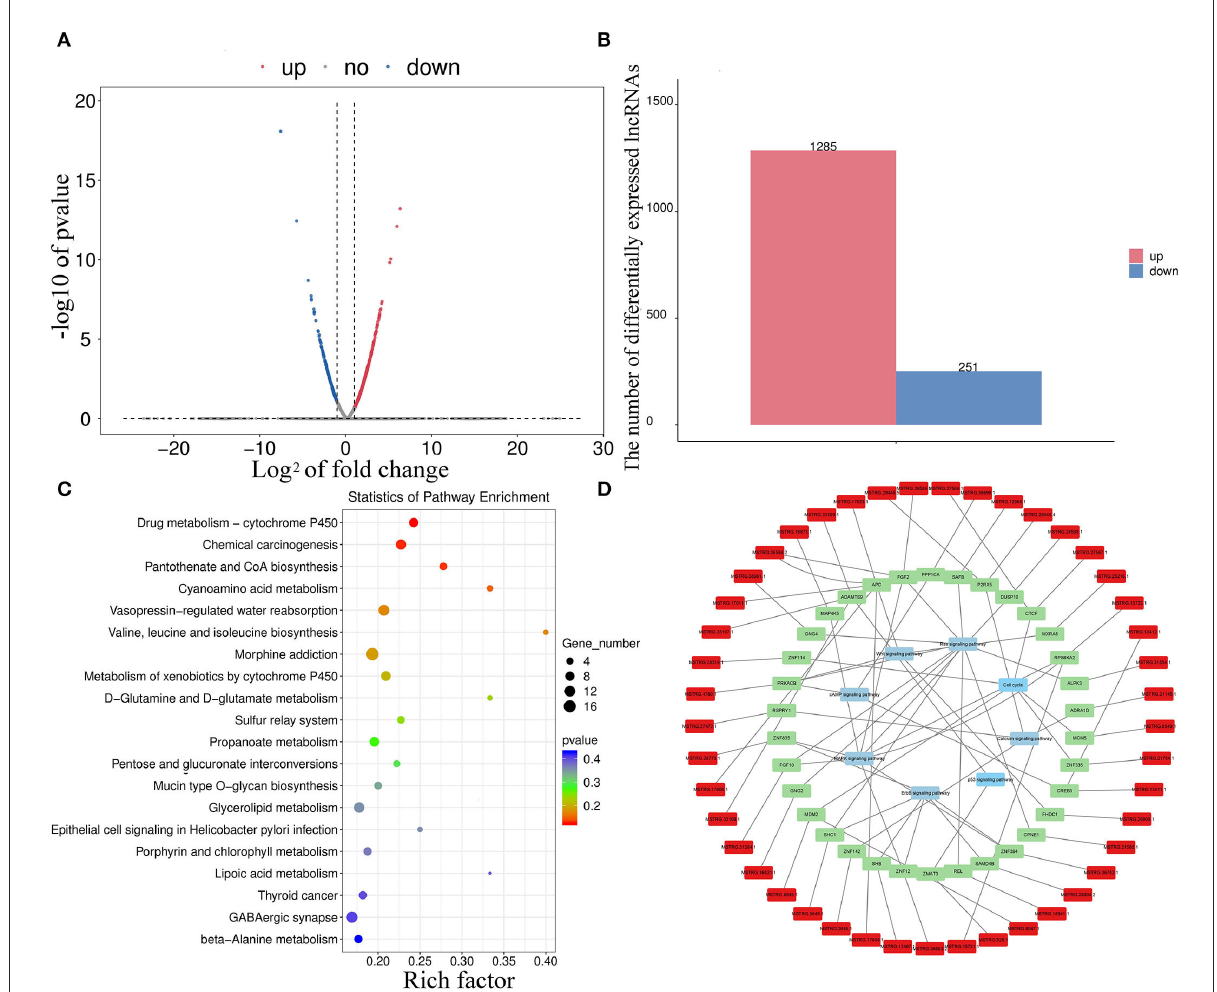
FIGURE5 Divergent expression patterns of lncRNAs in melanocytes isolated from Boer goat skins with white and brown hairs. (A,B) Divergent expression patterns of lncRNAs in melanocytes. (C,D) The target gene of DEL annotation results was obtained using the KEGG database; red symbols mark DELs, green marks target genes of DELs, and blue marks key signaling